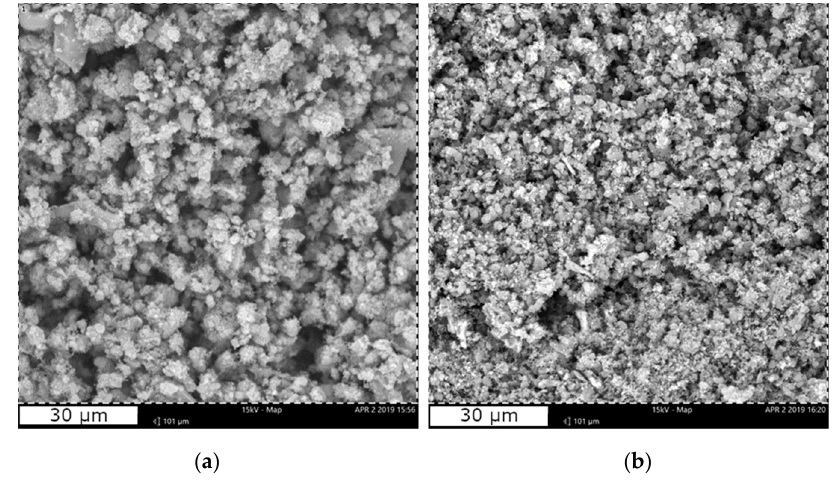
Figure 1. SEM micrographs of ( a ) CaBG and ( b ) SrBG bioglass particles.